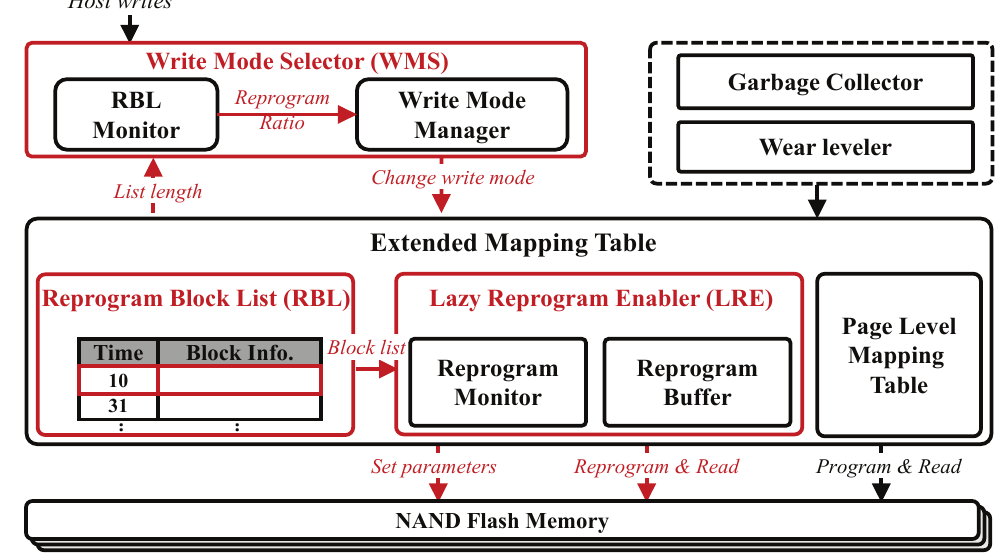
Figure 6. An overview of the LazyRS-aware